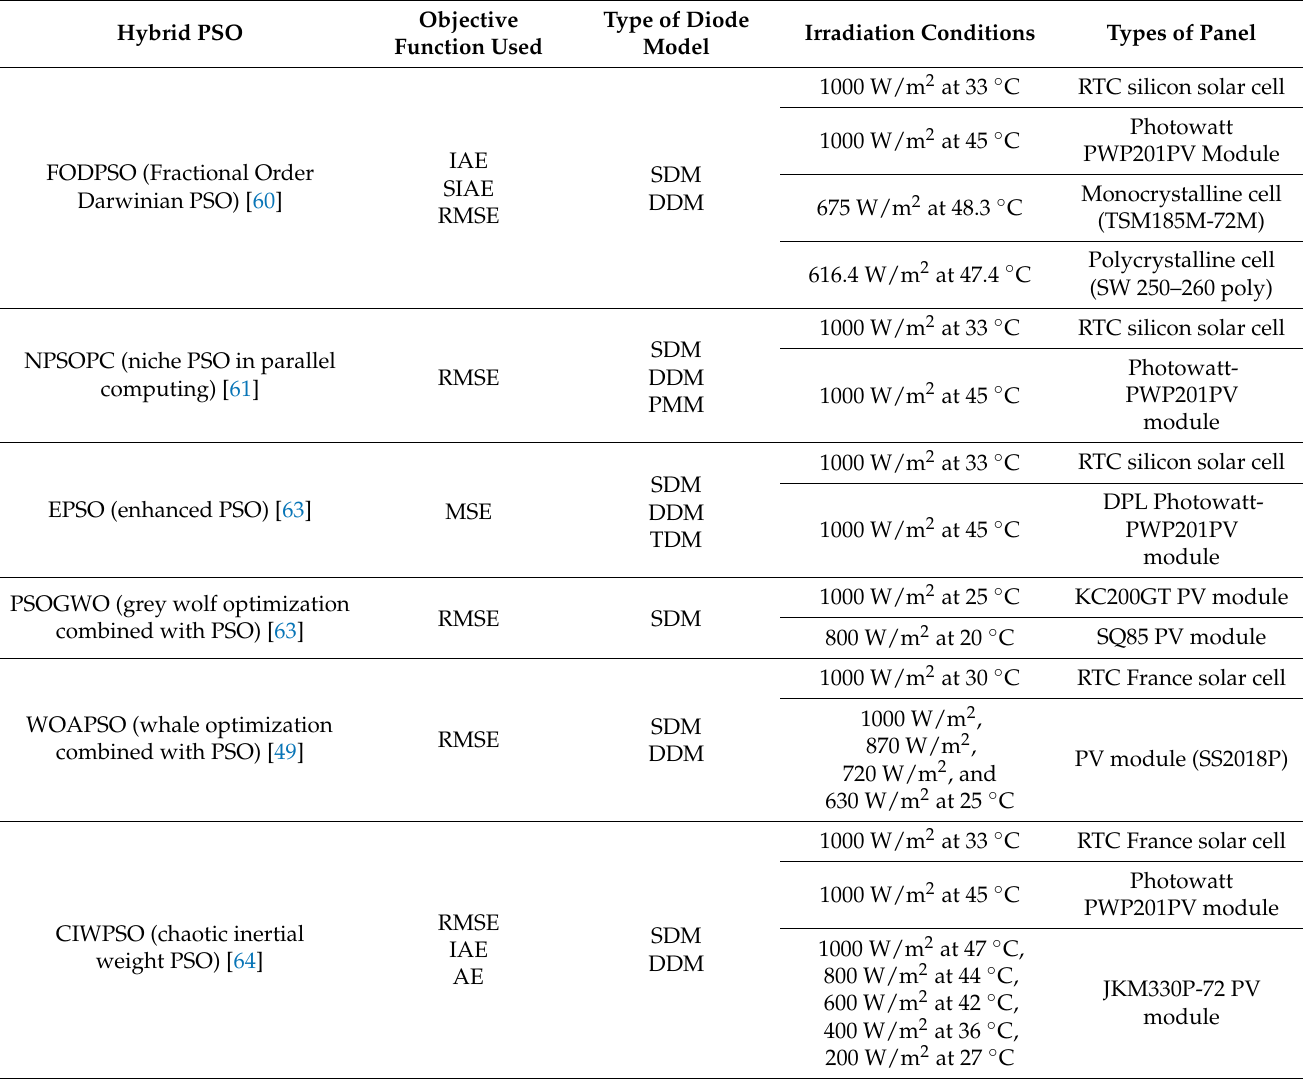
Table 2. Comparison of different hybrid PSO algorithms for parameter approximation of PV